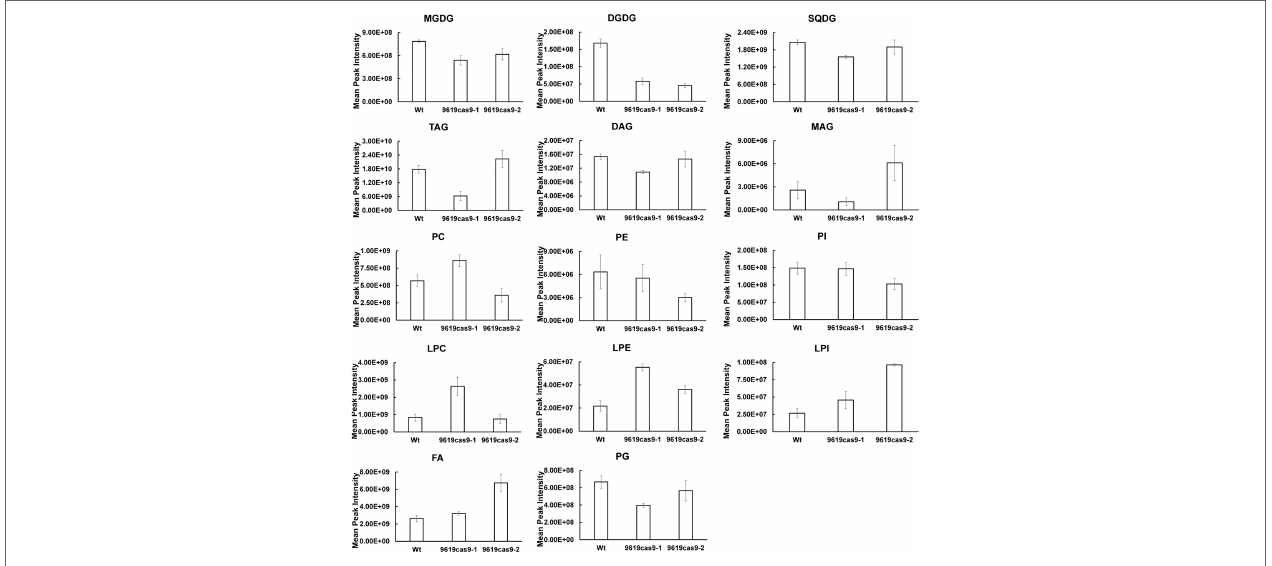
FIGURE 6 | Major Lipidomic Profiling of Wt and the ptMGD2 mutants. MGDG, monogalactosyldiacylglycerol; DGDG, digalactosyldiacylglycerol; SQDG, sulfoquinovosyldiacylglycerol; TAG, triacylglycerol; DAG, diacylglycerol; MAG, monoacylglycerols; PC, phosphatidylcholine; PE, phosphatidylethanolamine; PI, phosphatidylinositol; LPC, lysophosphatidylcholine; LPE, lysophosphatidylethanolamine; LPI, lysophosphatidylinositol; FA, free fatty acids; PG,